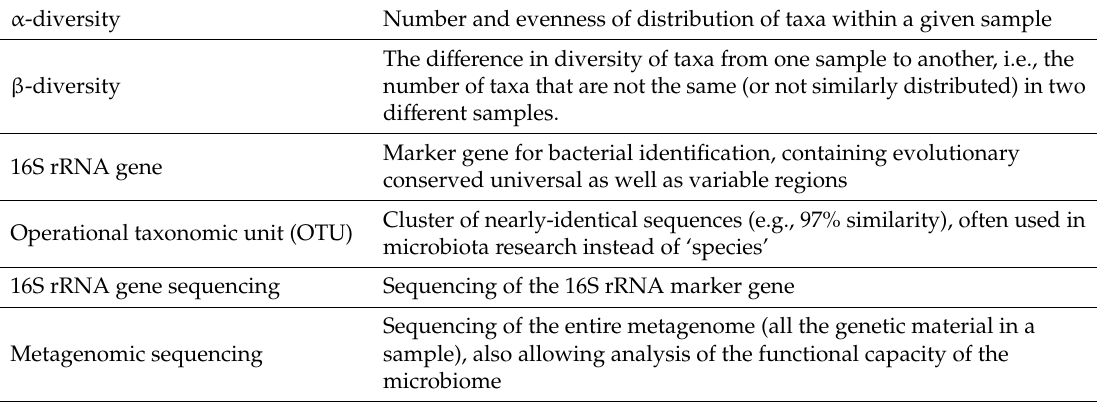
Table A2. Definition of terms used in microbiota research